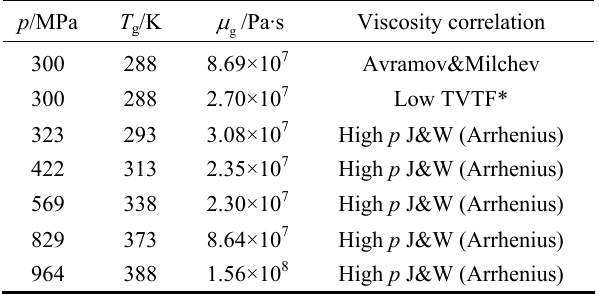
Table 2 The glass transition state (pressure and temperature) from the Oels and Rehage equation (1) and the viscosity calculated by the given correlation.